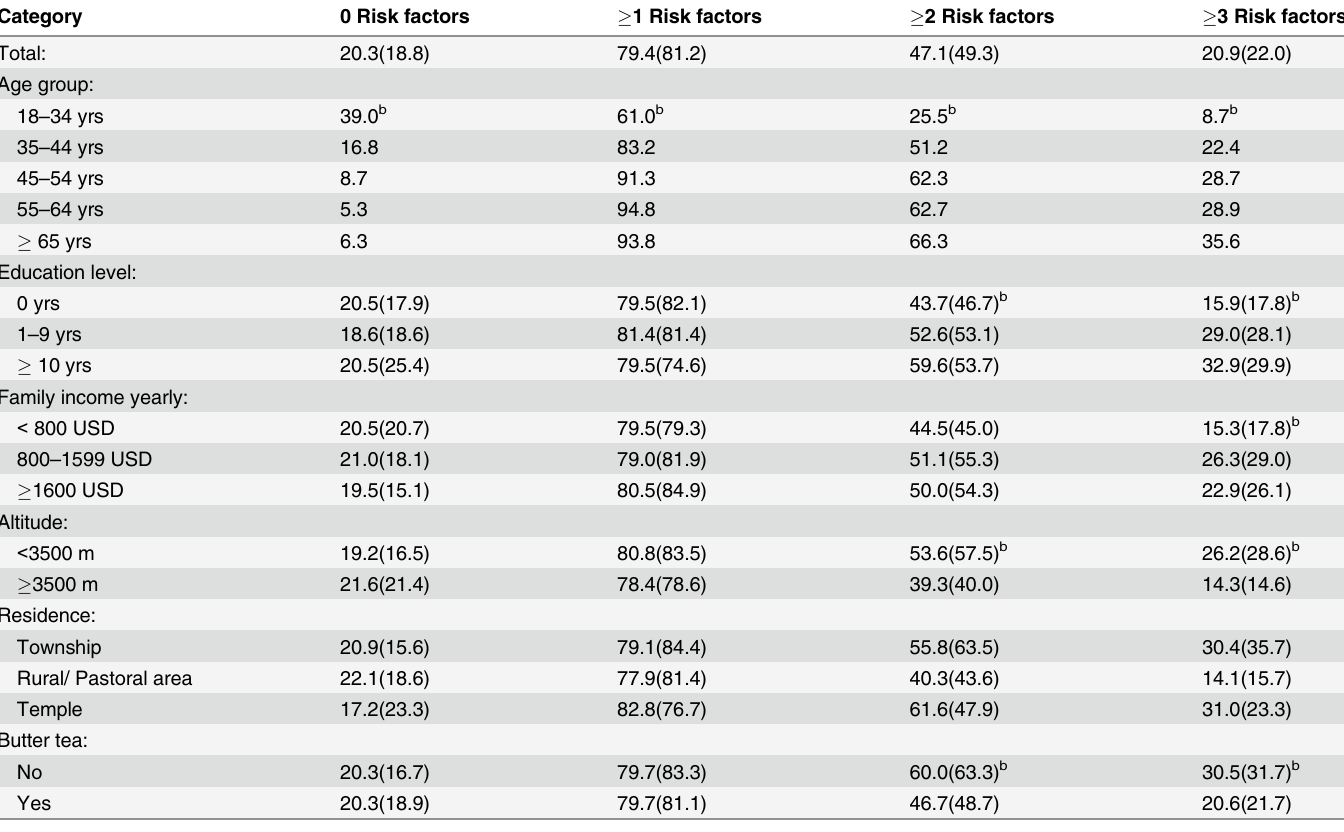
Table 4. The age adjusted prevalence with different numbers of CVD risk factors among Tibetan adults. a